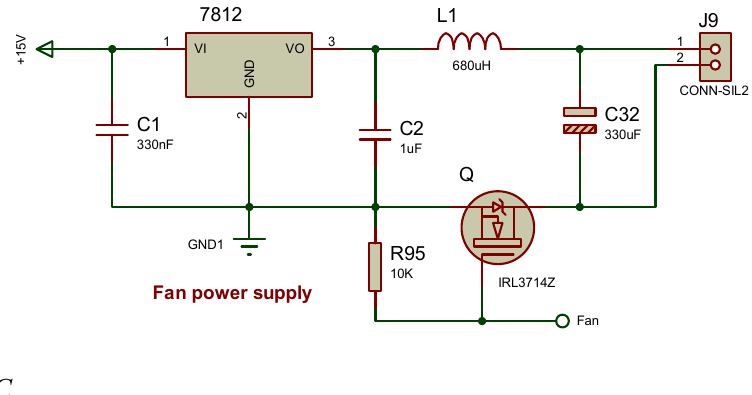
Figure 21. SSC slave control circuit ISIS model Part 3: the module cooling fan supply and control circuit.